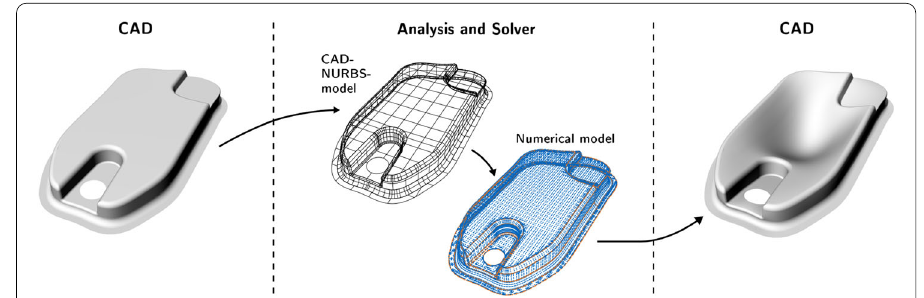
Fig. 1 The gap between CAD and computational models. The desired work flow from CAD to CAD is displayed here. Geometries which are used for design in CAD will be the bases for numerical models